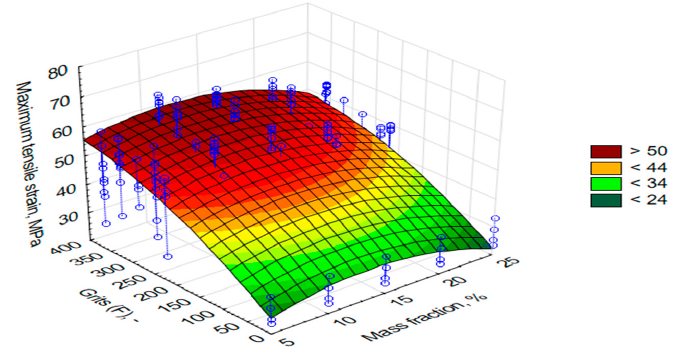
Figure 7. Graph of max principal stress values for samples made with L285 resin and H285 hardener with an addition of alundum with the following grains: F220, F240, F280, F320, and F360, with various percentage mass